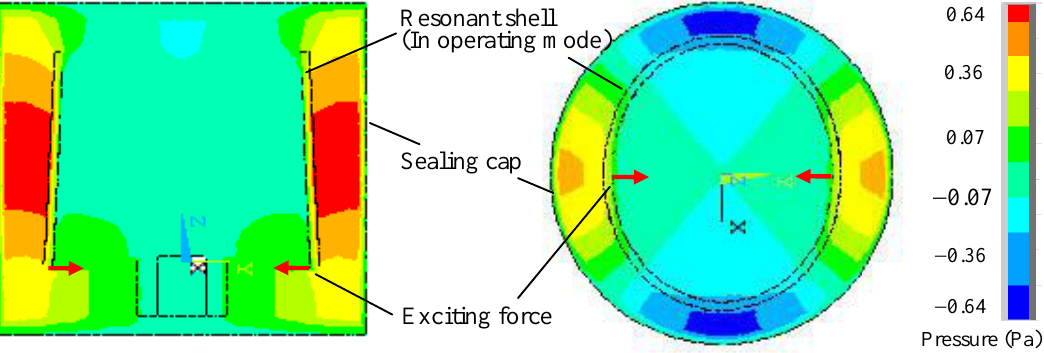
Figure 4. Acoustic pressure contour of the vibratory cylinder